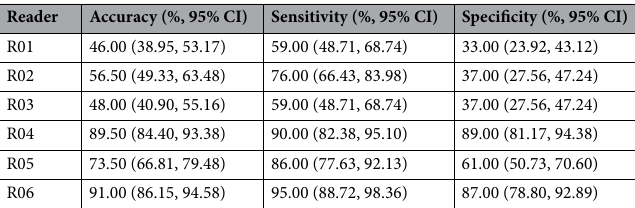
Table 1. Performance of the first image Turing test.